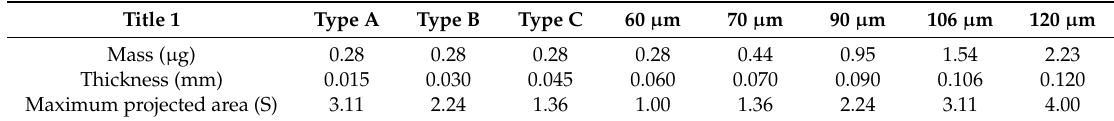
Figure 2. Particle shapes in numerical simulation. Table 1. Parameters of particles in the numerical simulation.